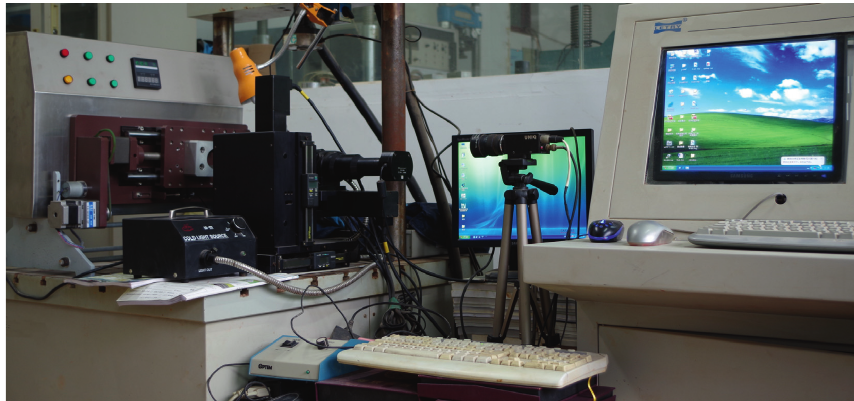
Figure 9: The overall picture of the testing system.